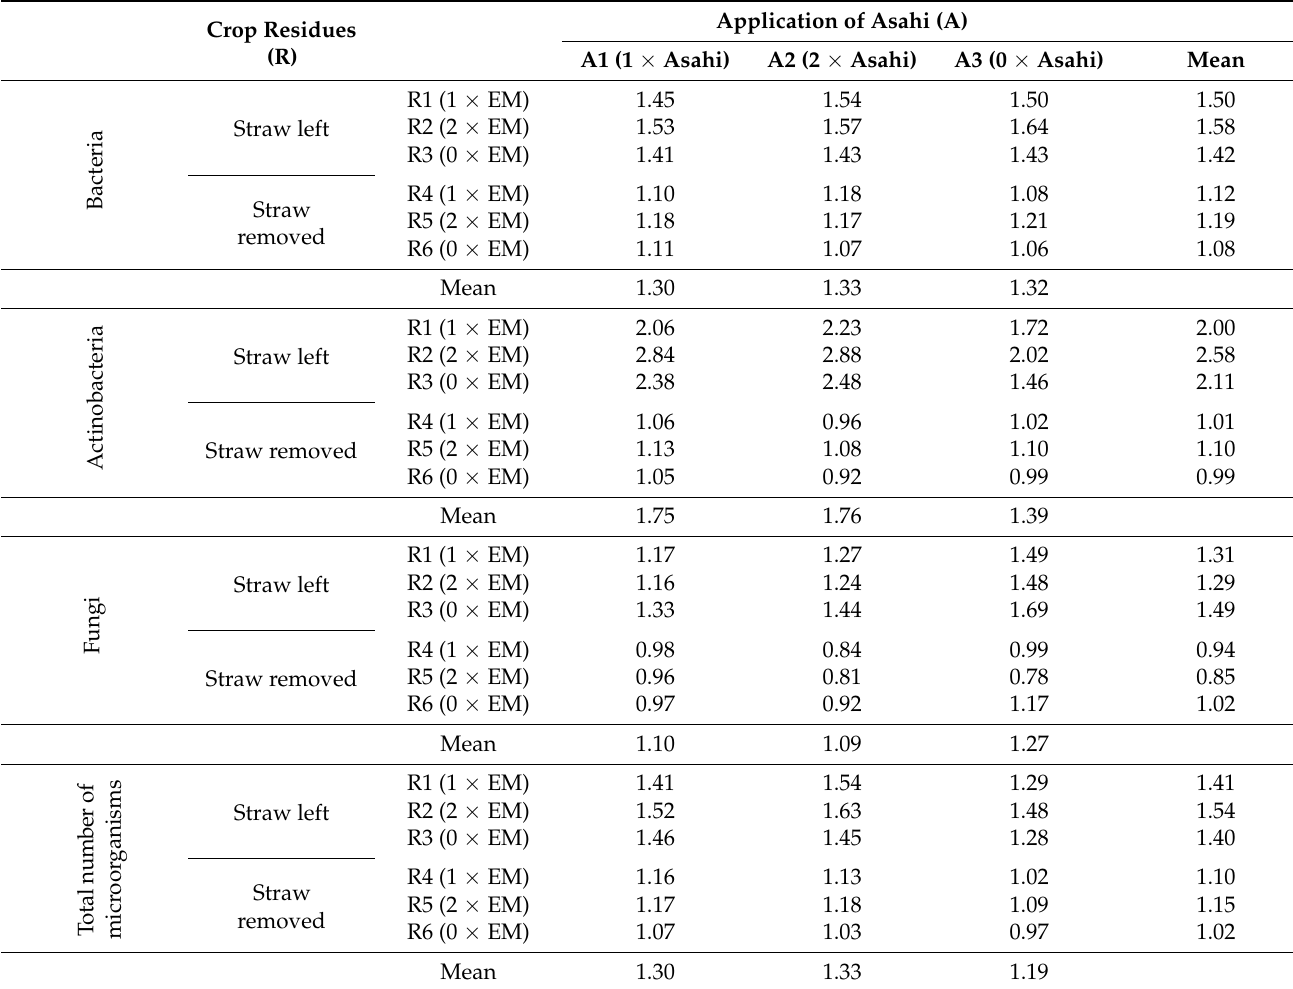
Figure 2. The number of actinobacteria in the soil, depending on the management of plant residues with the addition of the biopreparation EM (R factor) and the application of the biostimulant Asahi (A factor) in spring barley cultivation. Error bars represent standard deviation (abbreviations: see Table 1).